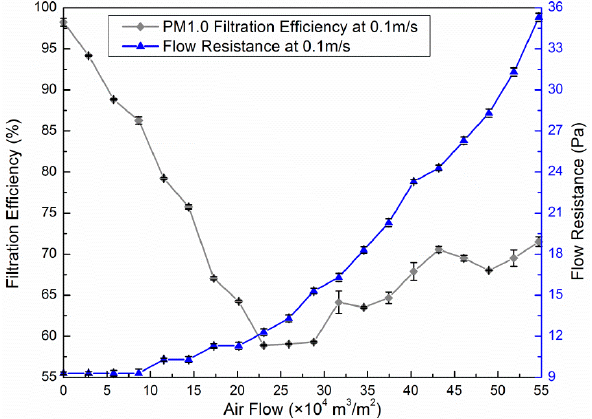
Figure 7. PM 1.0 efficiency and pressure drop curves of an electret filter medium.